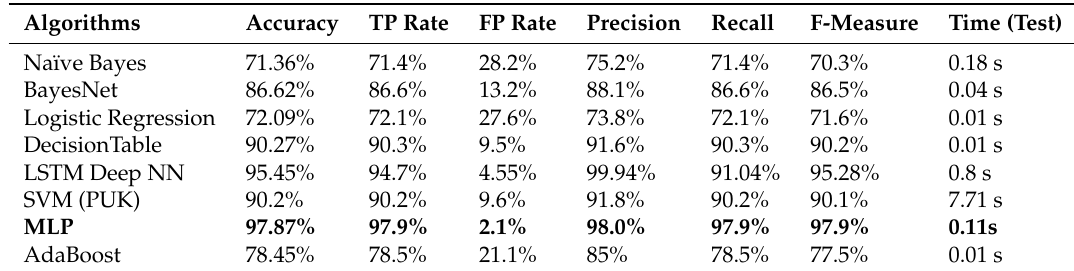
Table 4. Performance evaluation for attack scenario 1.